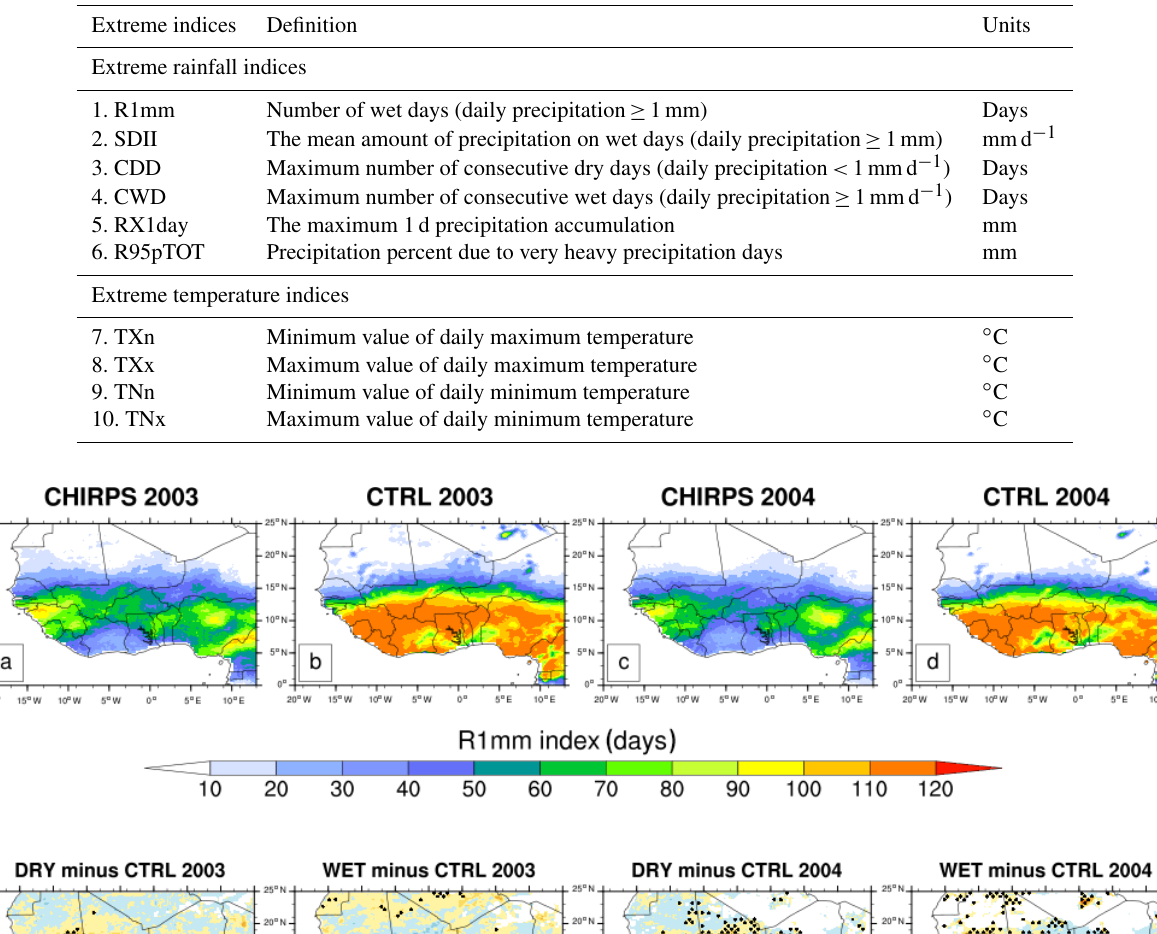
Table 1. The 10 extreme climate indices used in this study.